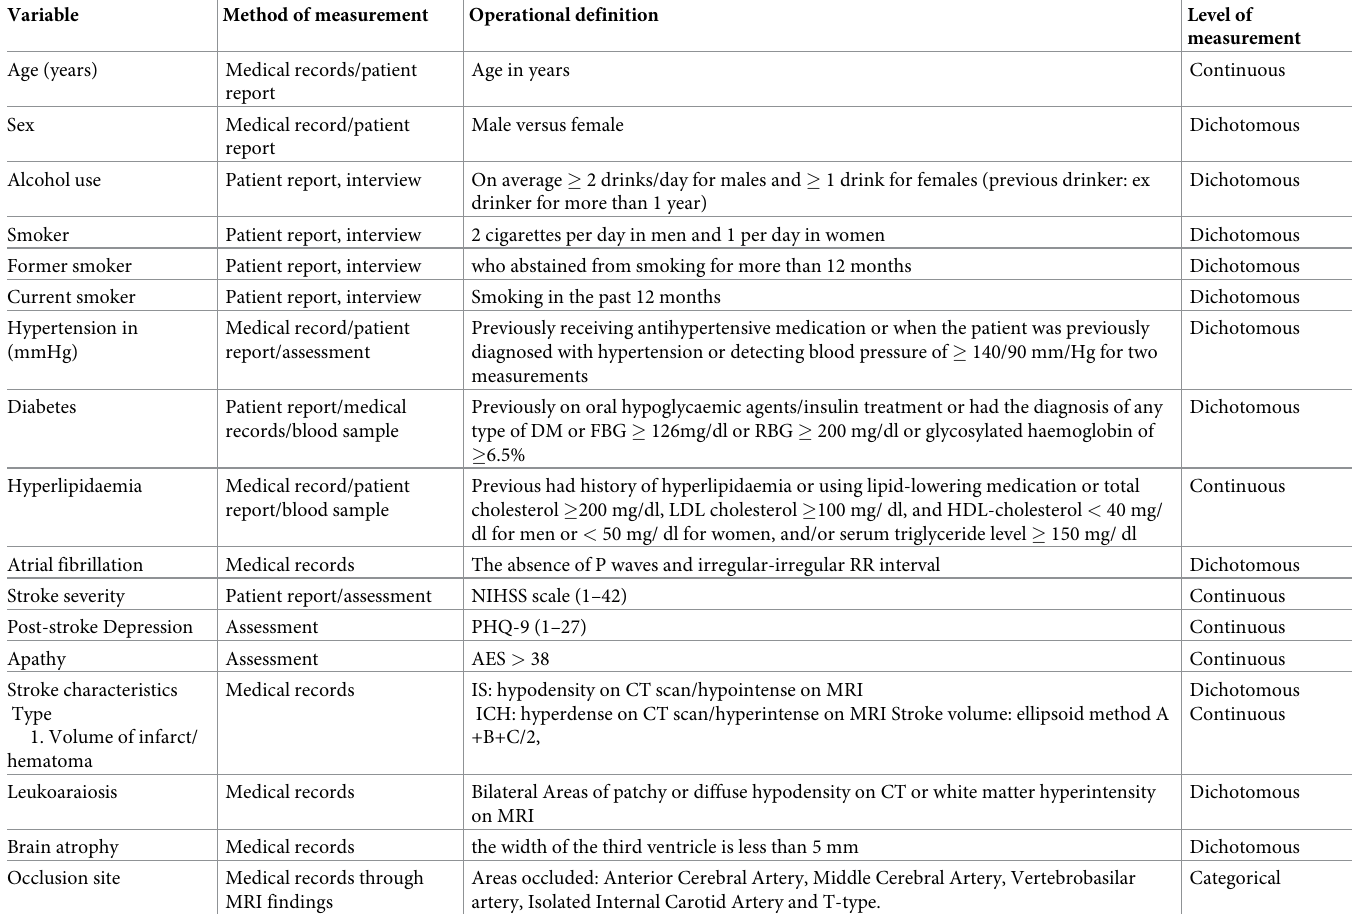
Table 3. Summary and description of objective number 3 variables of the